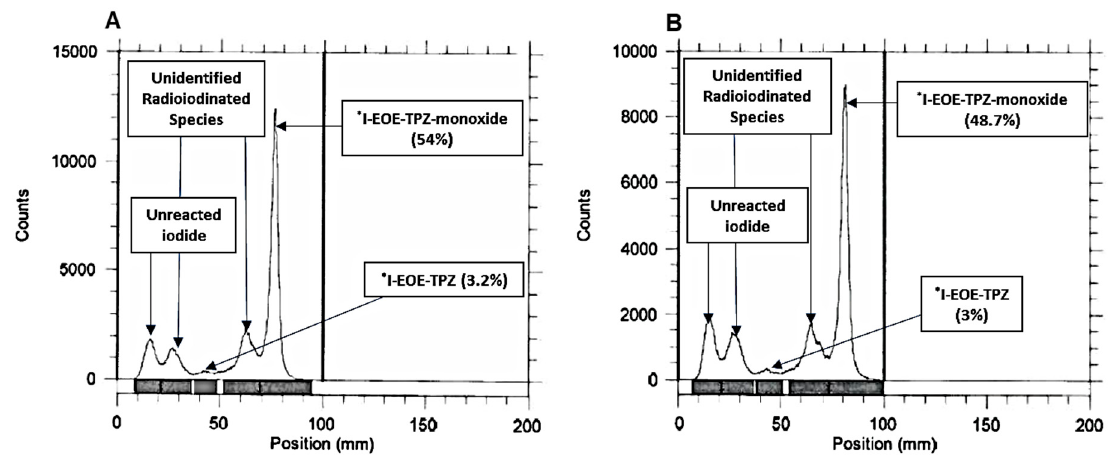
Figure 5. RTLC of the exchange reaction mixture using precursor P2 and pivalic acid in ACN after 30 min ( A ) and 90 min ( B ) at 22 °C.